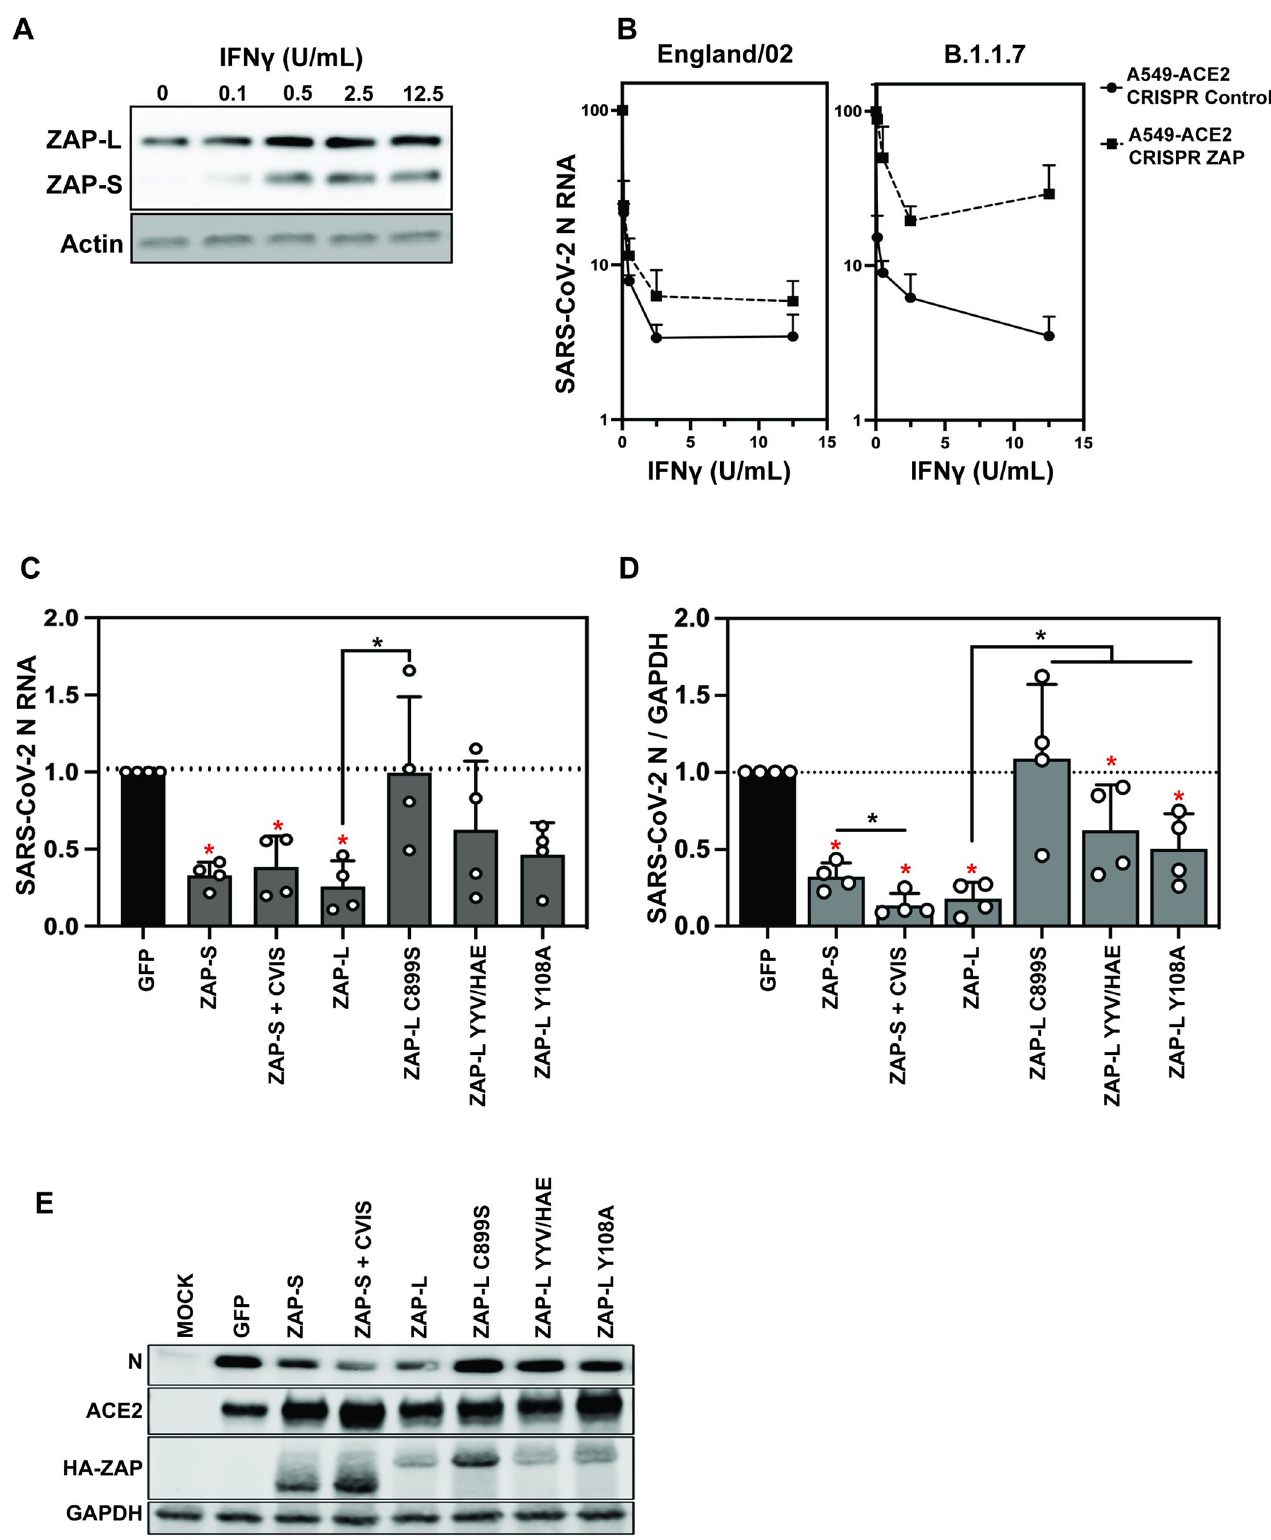
Fig 6. ZAP-L requires the CaaX box to restrict SARS-CoV-2. (A) Western blot showing IFN γ -mediated induction of ZAP-L and S in A549-ACE2 cells. ( B) IFN γ treatment restricts early-pandemic SARS-CoV-2 strain England02 and B.1.1.7 variant of concern infection less potently in CRISPR ZAP cells